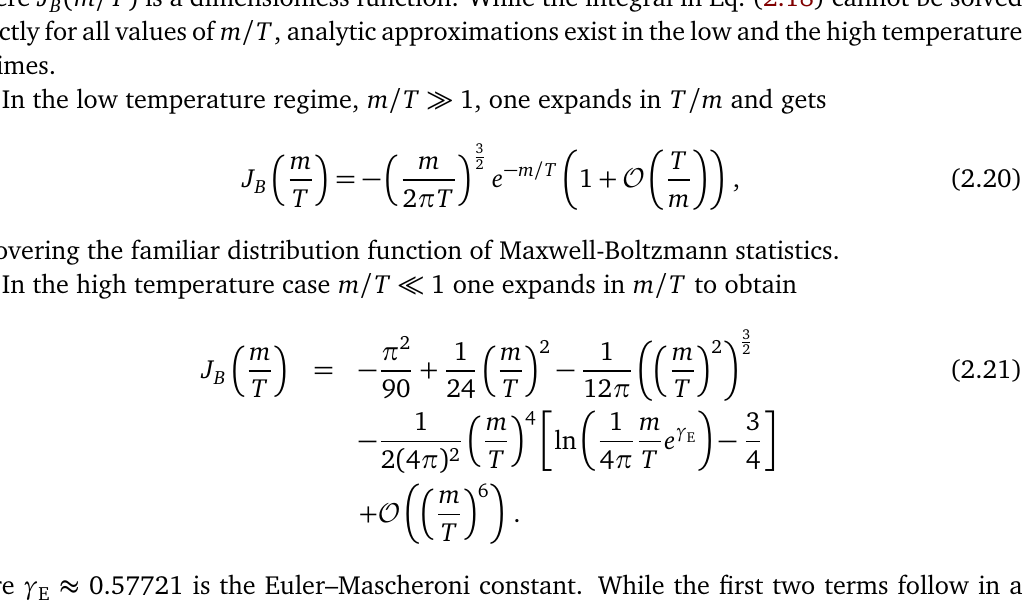
Figure 1: This figure shows the dimensionless function J free energy of bosons as defined in Eq. (2.19), as a function of mass-to-temperature ratio (thick line). Also the expansions for large T (dashed), Eq. (2.21) and small T (dotted), Eq. (2.20) are shown. The large-T expansion is performed up to order four in m / T , being a good approximation up to m / T ∼